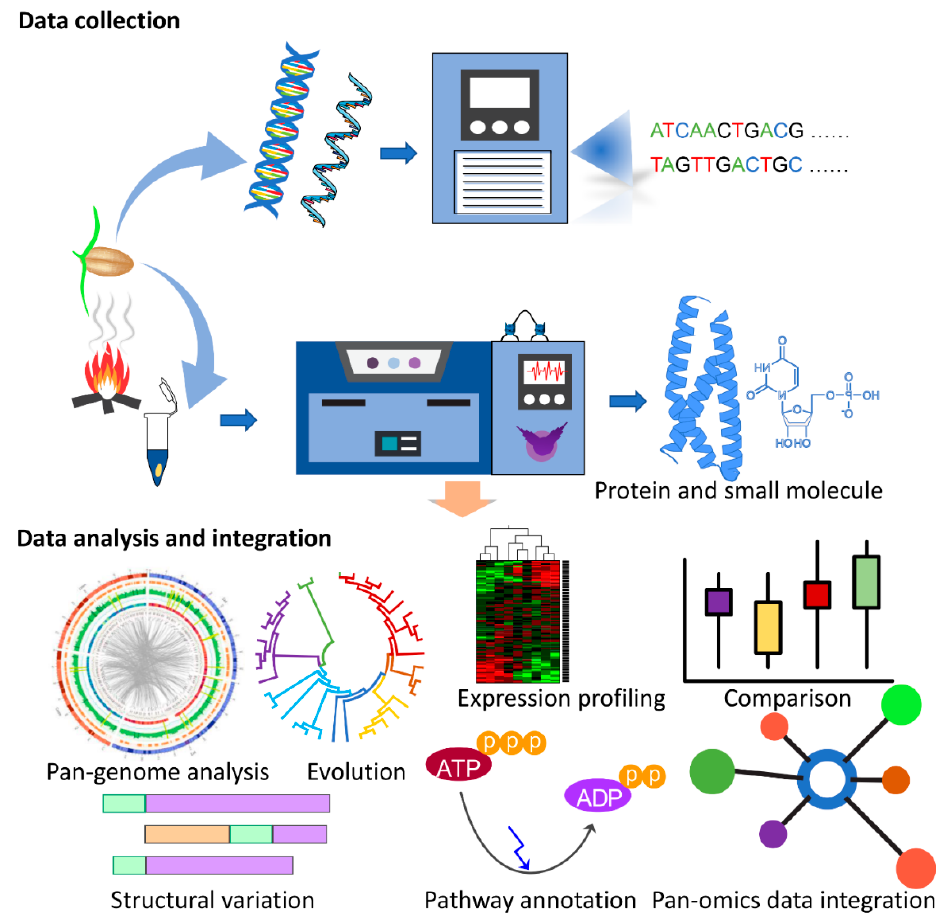
Figure 1. Multi-omics experimental strategy for decoding karrikin (KAR) signalling pathways in crops. The first step is to collect omics data and then analyse and integrate the data in combination to identify the key regulatory mechanisms in plants.